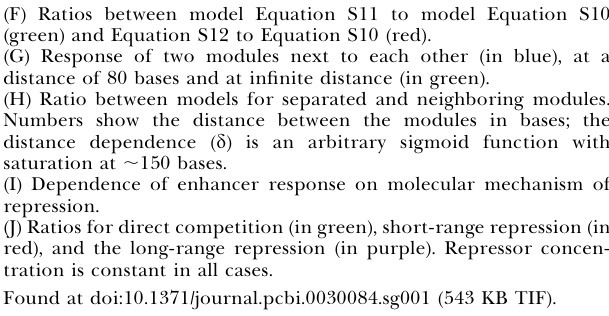
distance dependence ( d ) is an arbitrary sigmoid function with saturation at ; 150 bases.